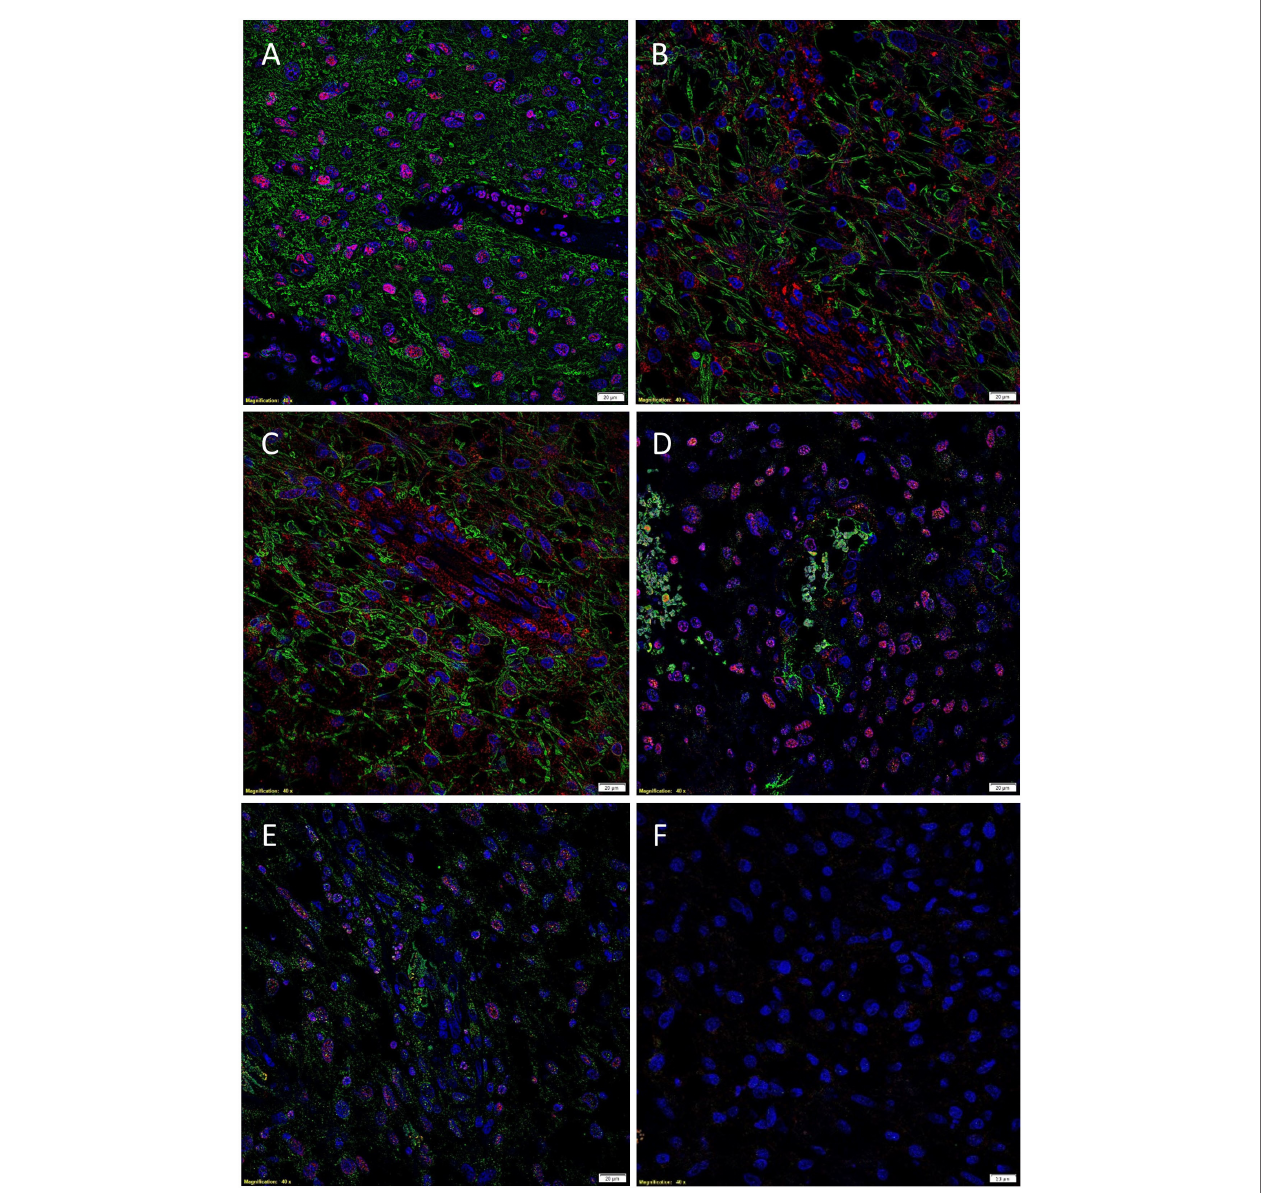
FigUre 2 | representative immunofluorescent immunohistochemical stained images demonstrating the expression of sOX2 [(a), red], Prr [(B), red], and aTiir2 [(c), red] on gFaP + cscs [(a–c), green] and expression of ace [(D), green] and aTiir1 [(e), green] on sOX2 + cscs [(D,e), red] . Negative control was a GBM tissue section with omission of the primary antibody (F) . Cell nuclei were counterstained with 4 ′ , 6 ′ -diamidino-2-phenylindole [ (a–F) , blue]. Scale bars: 20 μ